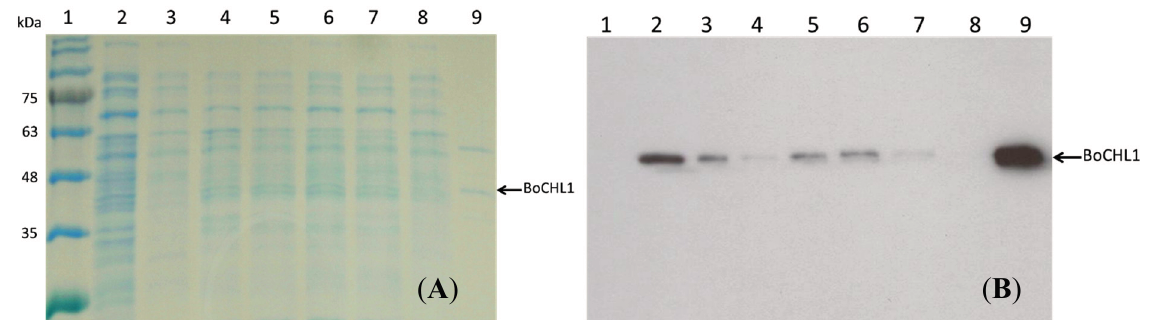
Figure 2. Absorption capacity of metal chelators for metal ions. ( A ) SDS-PAGE analysis of the spent cell lysate after the adsorption of proteins with metal ion-loaded DIAION ® CR11. ( B ) Western blot was performed using a monoclonal anti-His tag antibody. Lane 1: marker, Lane 2: crude cell lysate, Lane 3: Fe(II), Lane 4: Co(II), Lane 5: Mn(II), Lane 6: Zn(II), Lane 7: Ni(II), Lane 8: Cu(II), Lane 9: purified BoCLH1 (38.63 kDa) was used as a positive control. The arrow indicates the location of recombinant